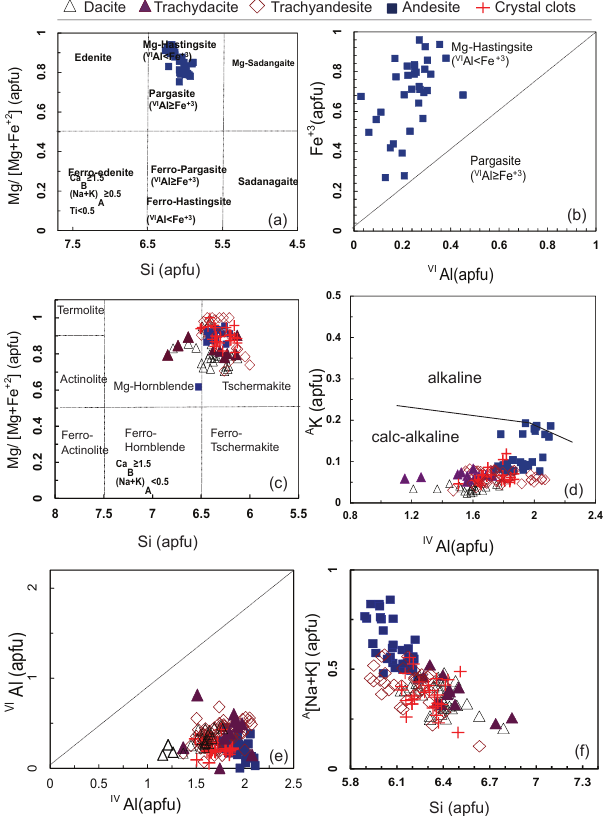
Fig. 9 Figure 9. Major element classification diagrams for amphiboles. (a) Amphiboles in the Mg-andesite samples. (b) Amphiboles in an- desites with V1 Al < Fe + 3 fall in the Mg-hastingsite field. (c) Am- phiboles in the trachyandesite, trachydacite, dacite samples and am- phibole from crystal clots on the Mg / (Mg + Fe 2 + ) vs. Si classifi- cation diagrams (after Leake, 1978, Leake et al., 1997, 2004). (d) A K vs. VI Al diagram after Ridolfi and Renzulli (2012) showing our calcic amphiboles in equilibrium with calc-alkaline liquids. (e) V1 Al plotted against IV Al per formula unit and (f) (Na + K ) A vs. Si per formula unit for amphiboles from all samples. Procedure for as- signing Al according to Leake (1978) and Leake et al. (2004). Solid black line in (e) indicates slope of